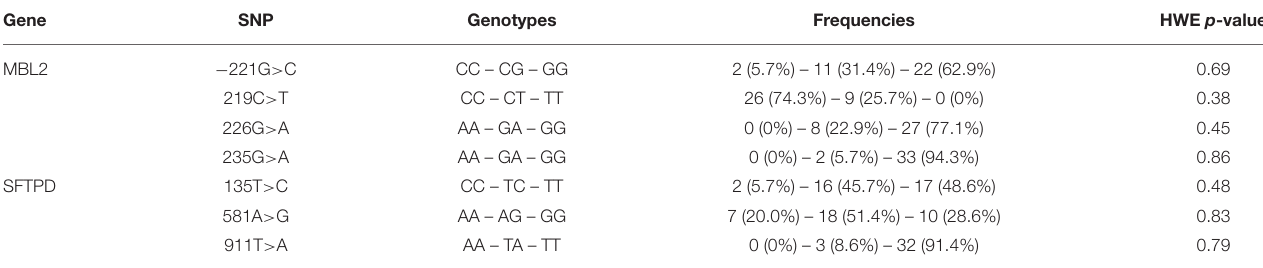
TABLE 2 | Distribution of genotypes in the study cohort.